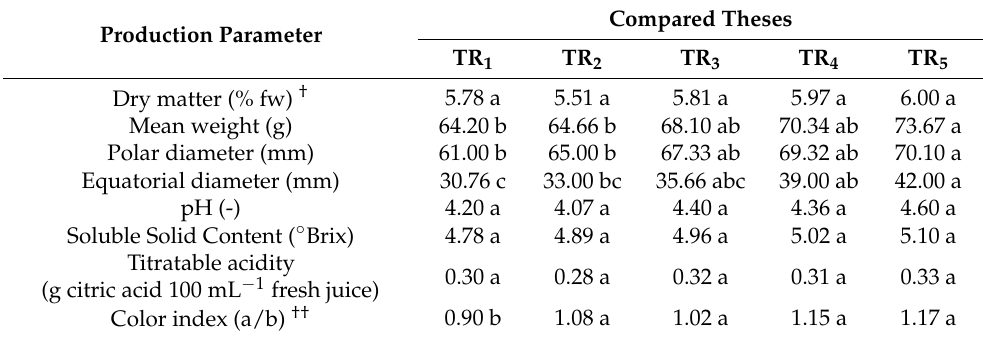
Table 9. Effect of fertilization management strategies on the main qualitative parameters of the processing tomato